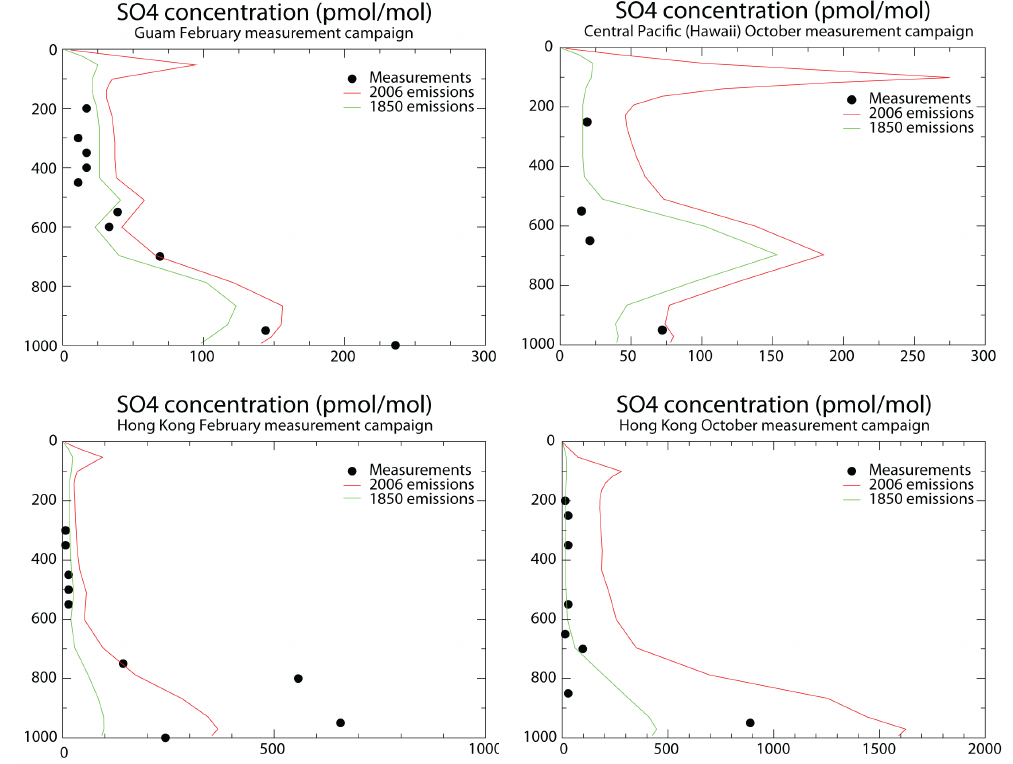
Fig. 5. Vertical profiles of SO 4 mixing ratios compared to flight measurements from the Pacific Exploratory Mission (PEM) over the period 1996–1999 presented in Barth et al. (2000). The circles denote measurements, and continuous red and green lines represent the Ctrl PD and PI simulations,